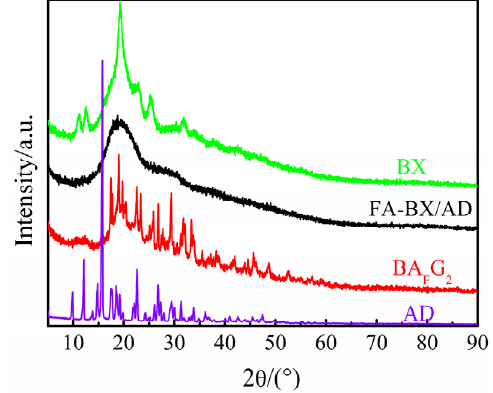
Figure 3. XRD profile of BX, AD, FA-BX/AD and BA F G 2 .